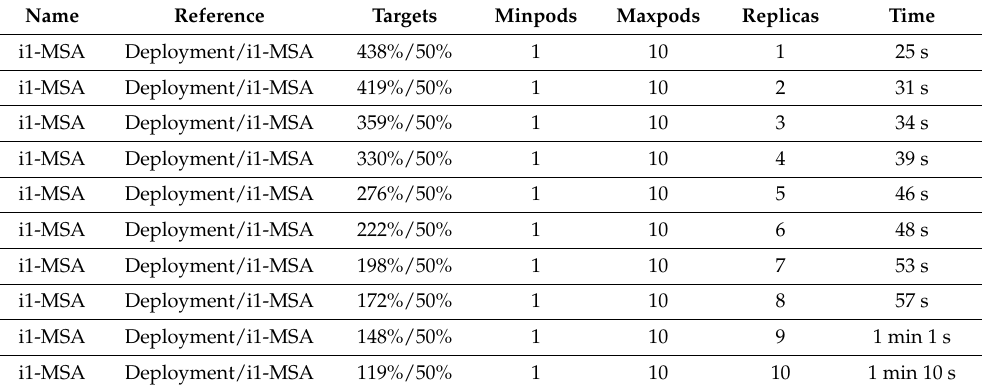
Table 3. DQN-based auto-scaling performance test results.